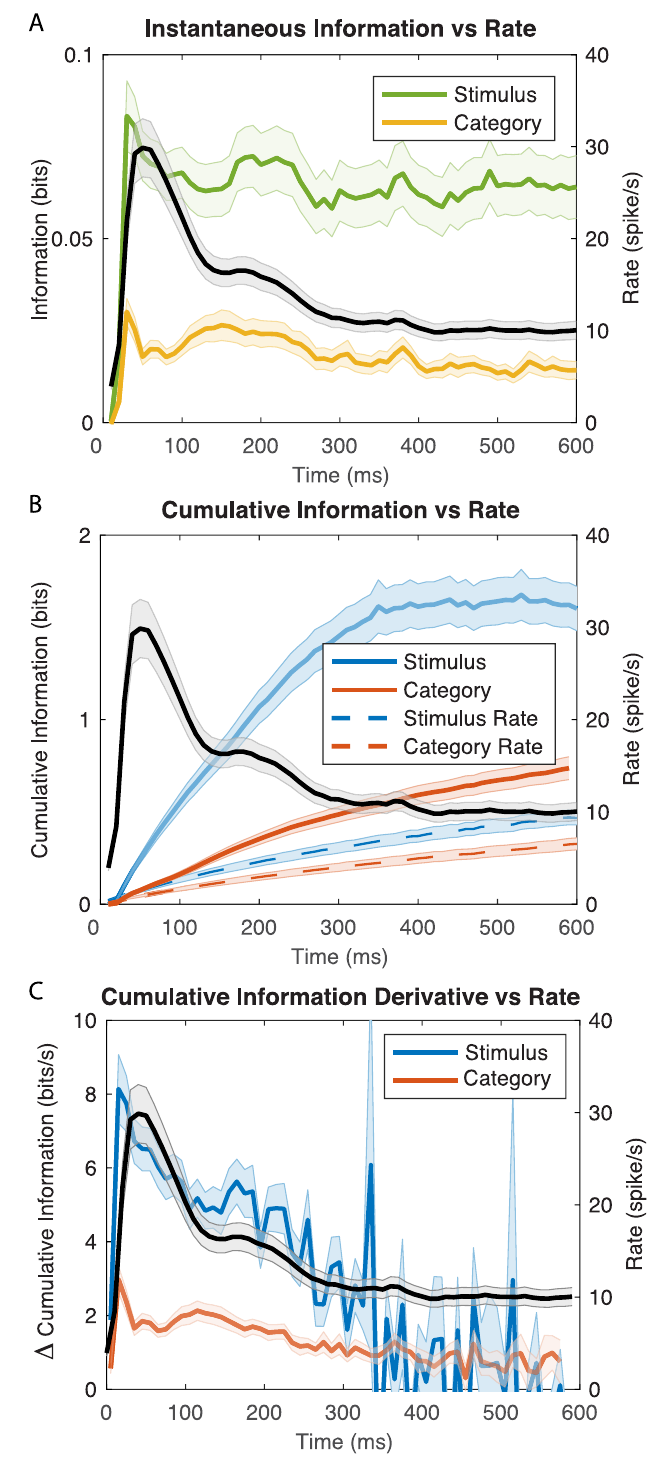
Fig 6. Time-varying firing rates and information values for the population. A . The solid black line (right y-axis) shows the time-varying firing rate averaged across all neurons (n = 337) and all stimuli played. The green and yellow lines (left y-axis) show the instantaneous information for stimuli and call-type categories respectively. B . The time- varying mean firing rate is shown as in A. The blue and red solid lines show the population average cumulative information for stimuli and call-type categories respectively. The blue and red dashed lines show the corresponding average cumulative information values calculated with constant averaged firing rates for each stimulus for each neuron over the first 600ms after stimulus onset (a fixed rate code). C . The same data as in panel B is plotted but with the derivative (or slope) of the cumulative information values. In all plots, the shaded error bars are ± 2 SEM.